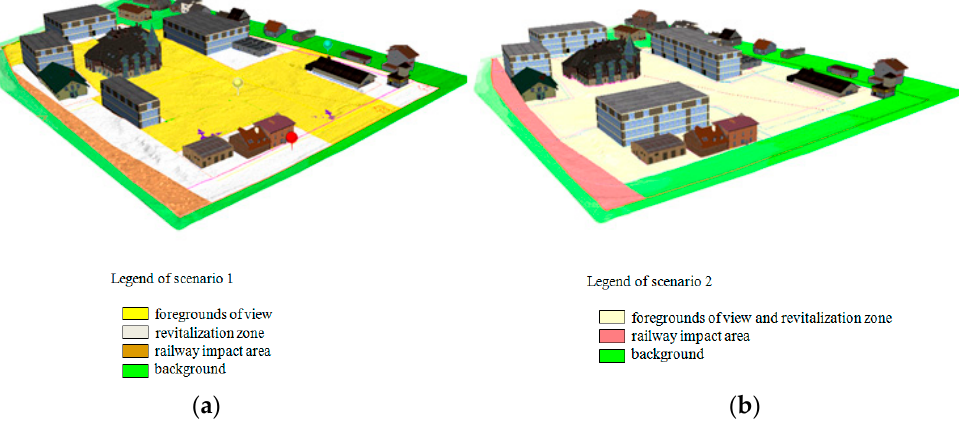
Figure 2. Two different planning concepts for the studied area resulting from the integration of the existing state in the field with the planned state based on the local development plan: ( a ) scenario 1, ( b ) scenario 2. Source: own work.